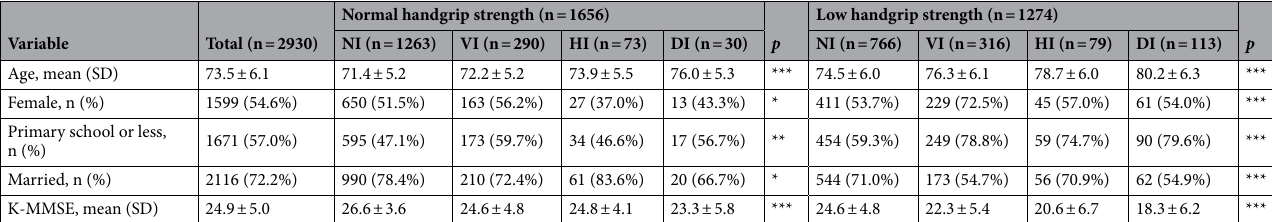
Table 1. Demographic characteristics of the participants stratified by handgrip strength status and type of sensory impairment at baseline. Analyzed using available data, including missing data. P value for the Pearson chi-square test for group comparisons of types of sensory impairment within each group of handgrip strength. DI dual sensory impairment, HI hearing impairment only, K-MMSE Korean version of